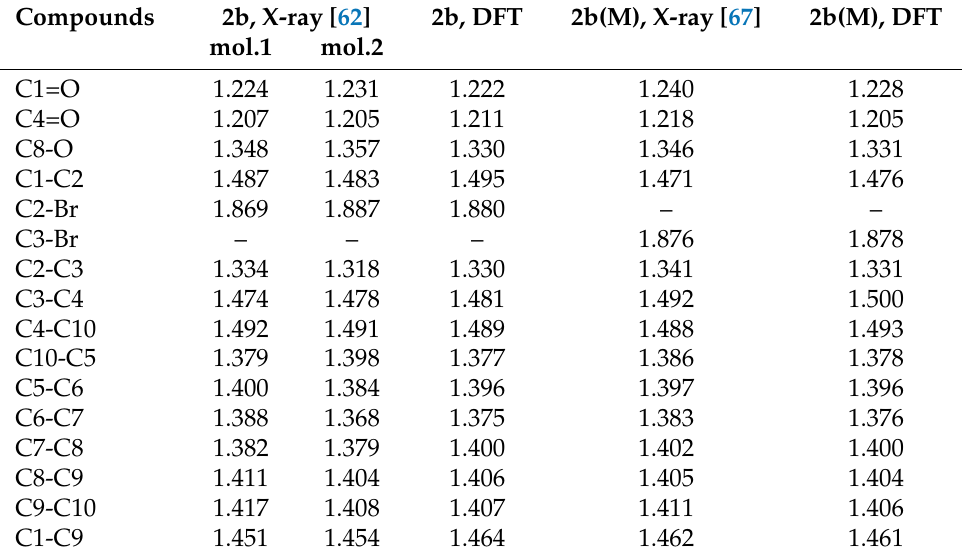
Table 3. Selected experimental (X-ray) and calculated ( ω B97XD/6-311++G(2d,2p) level) bond lengths (in Å) for the bromo-derivatives 2b and 2b(M) —see Figure 1 for the atom numbering scheme and structural